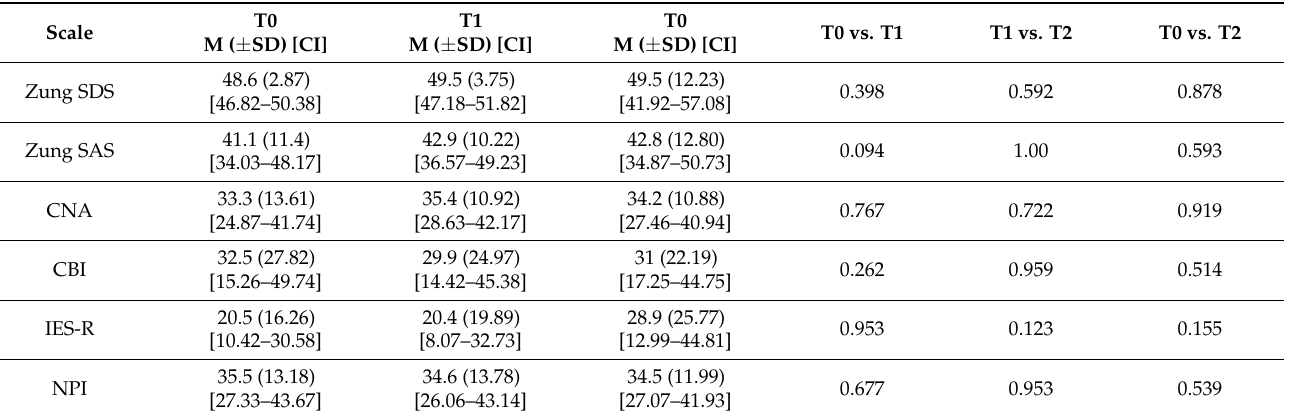
Table 4. Longitudinal assessment of measures of caregivers’ depression, anxiety, needs, burden, post-traumatic stressand neuropsychiatric symptoms in the